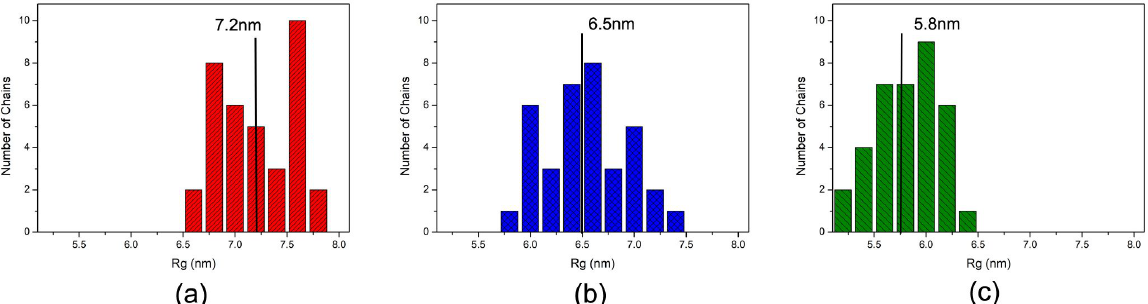
Figure 4: Histogram of Rg of the PI polymers interacting with a (a) SWCNT; (b) DWCNT; (c) TWCNT